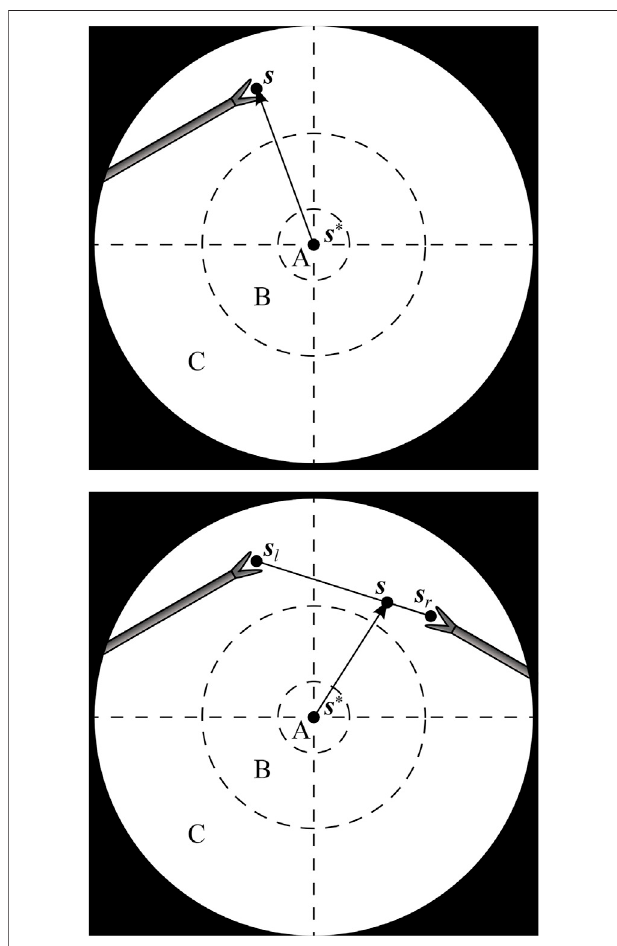
FIGURE 2 | Endoscopic view with one instrument tip at position s (top), andtwoinstrument tipsatpositions s l and s r ,combinedtoavirtualtipposition s (bottom). The AIT controller aims to make s coincide with a desired position s *.A,BandCarerespectivelythetarget,transitionandviolationzonesof a programmed position hysteresis